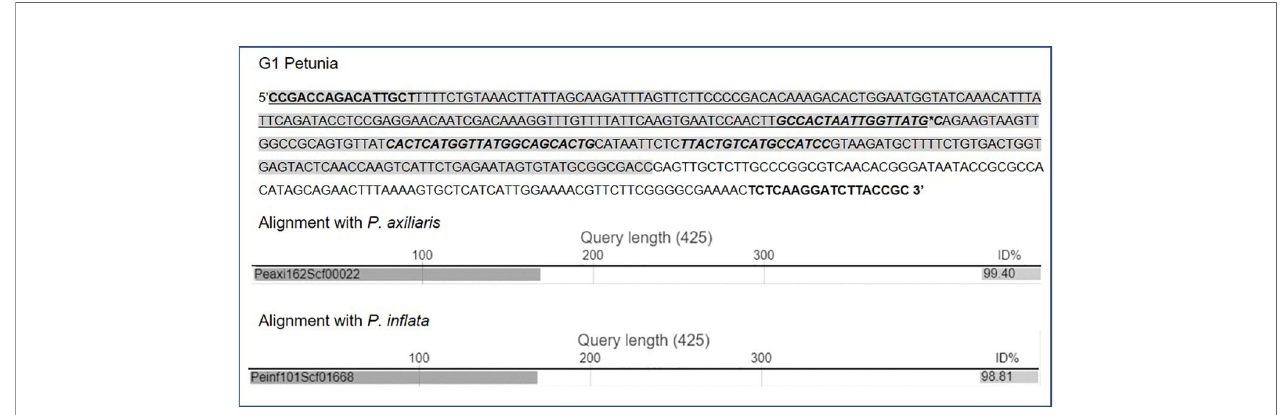
FIGURE 4 | Sequence data of the junction region present in G1 petunia as determined by MinION sequencing and con fi rmed by Sanger sequencing (sequencing primers in bold letters). The junction site is indicated (*). The shaded sequence part in G1 shows 100% identity to the sequence recently reported by Fraiture et al. (2019) including their predicted junction site. Underlined are sequences with identity to Petunia ssp. sequences (Solgenomics database; alignments shown below sequence). Location of G1 primers and probe are bold